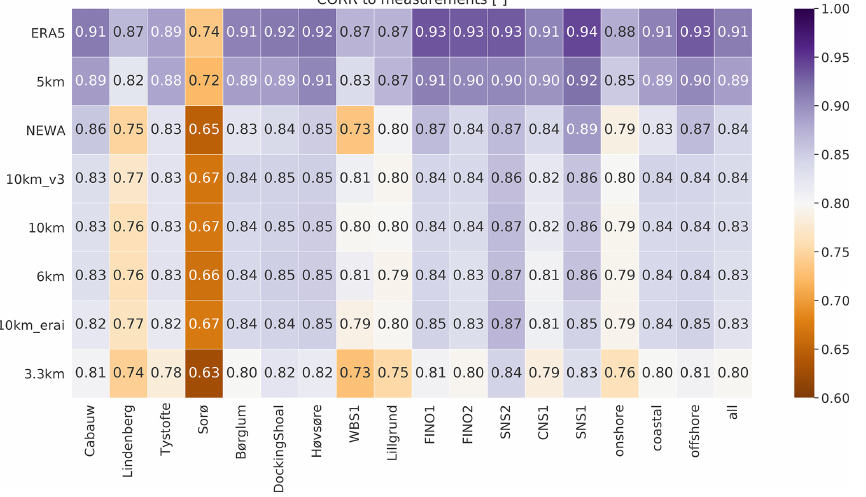
Figure 3. Correlation of simulated time series to measurements for the various experiments in Table 1 and reanalyses. The darkest purple colours are the most accurate metrics; the darkest brown is the least accurate. The rows are sorted by the column median all, with the most accurate results on the top and the least accurate results on the bottom of the table.